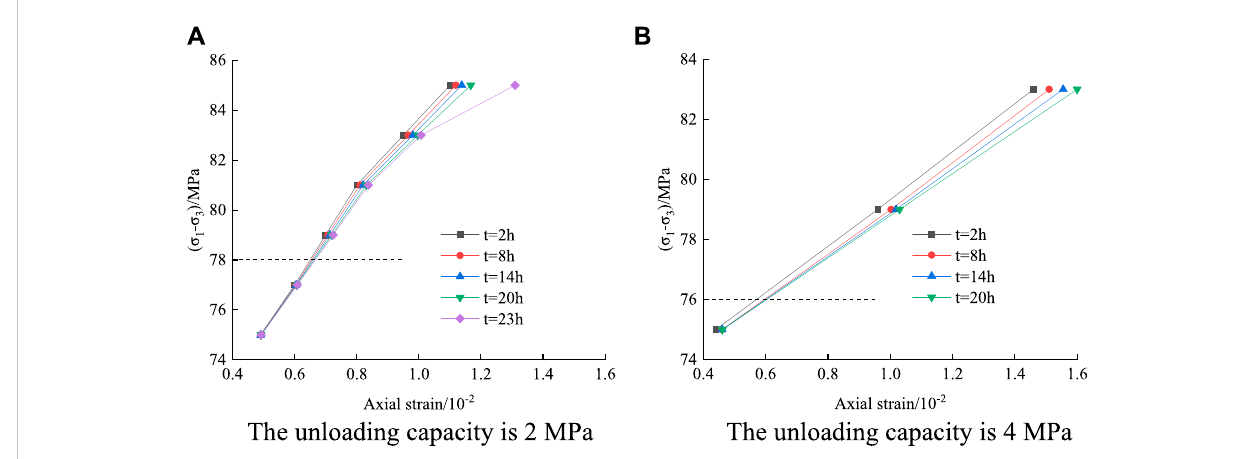
FIGURE 7 Creep isochronous curve clusters under different unloading amounts. (A) The unloading capacity is 2 MPa (B) The unloading capacity is 4